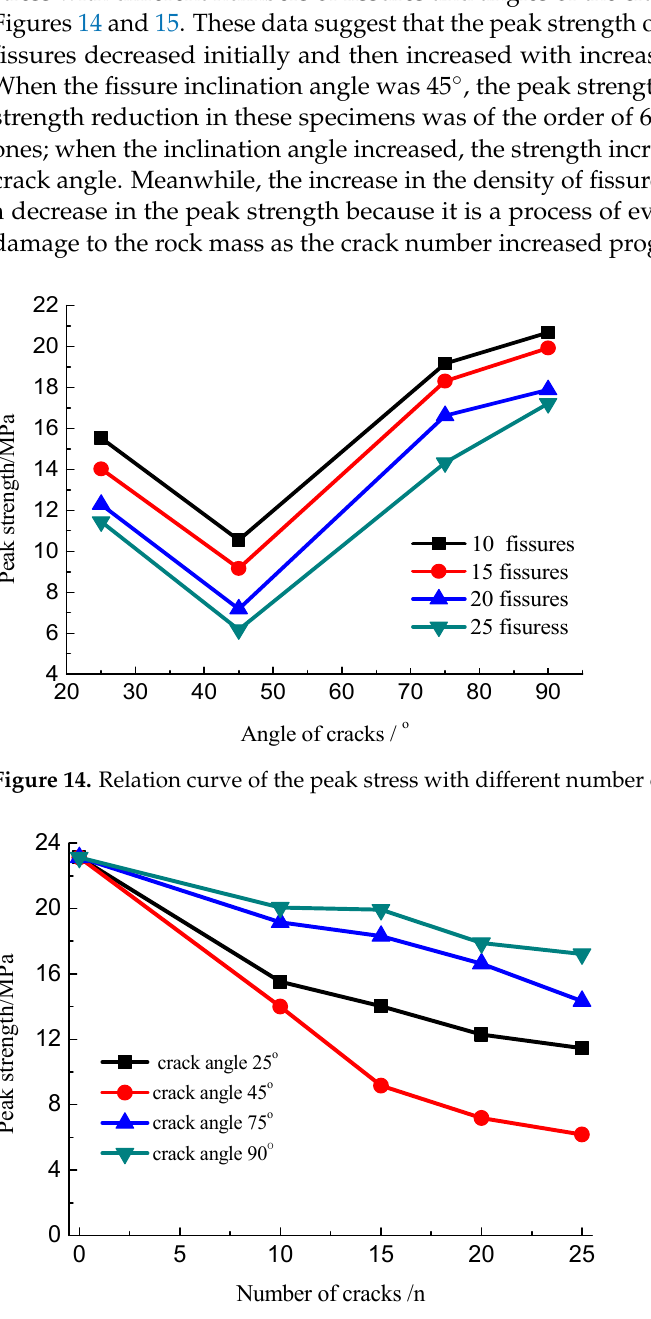
Figure 15. Relation curve of the peak stress under different crack angles.